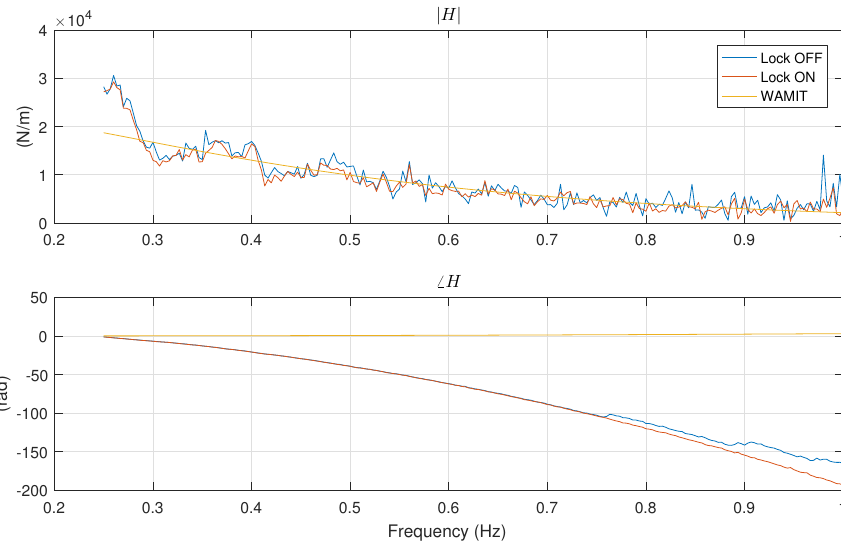
Figure 28. Excitation FRFs obtained from experiment with locked and unlocked device. The surface elevation is measured using the capacitive probe named